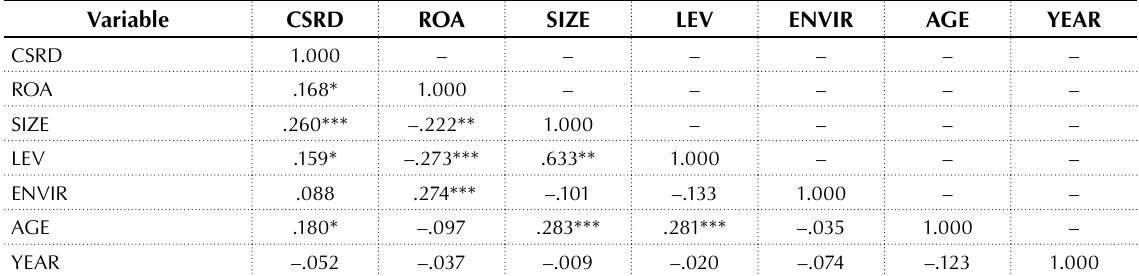
Table 4. Correlation matrix of variables